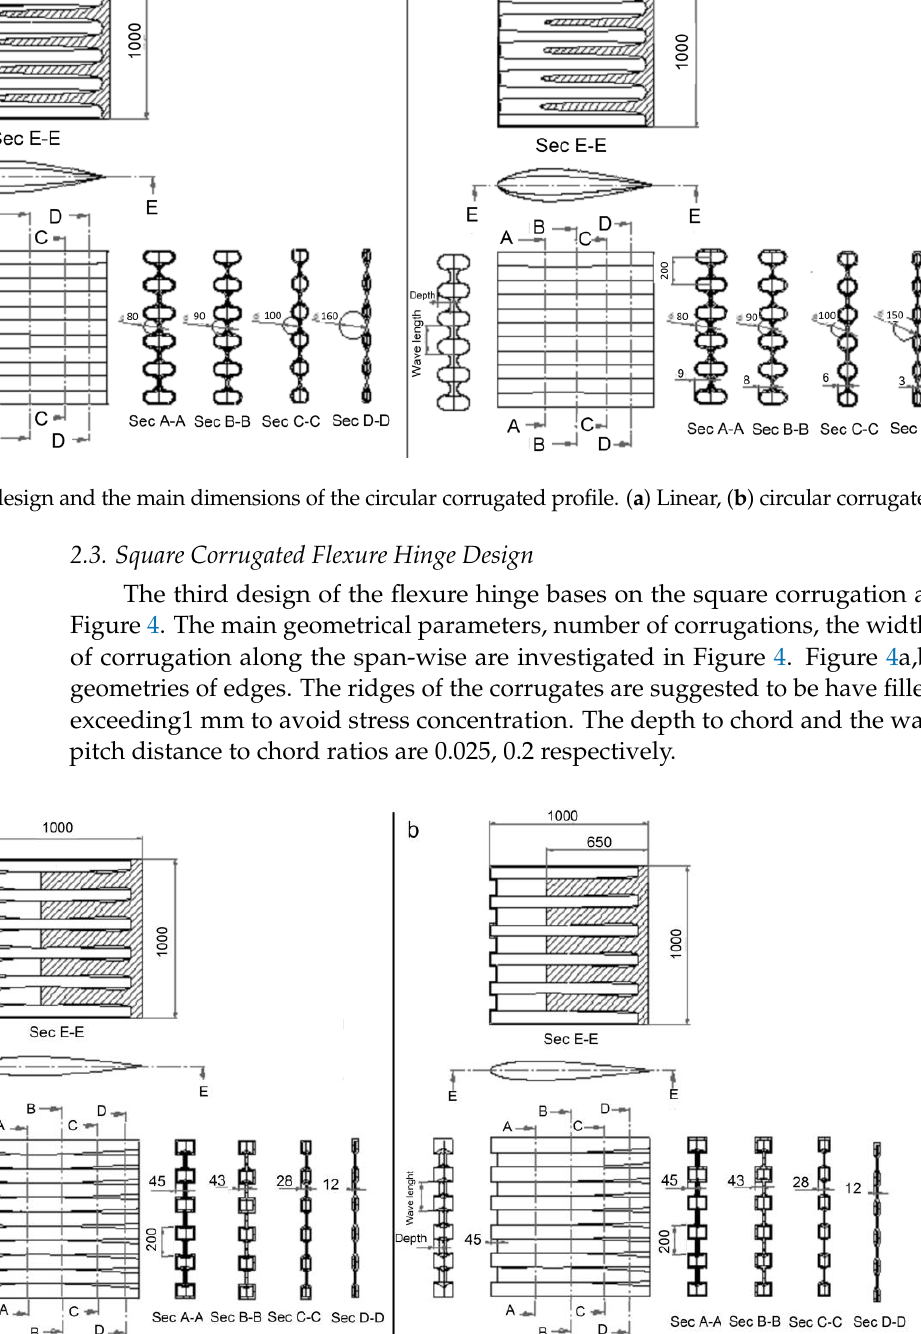
Figure 4. the detail design and the main dimensions of square corrugated profile. ( a )Linear edge, ( b )square corrugated